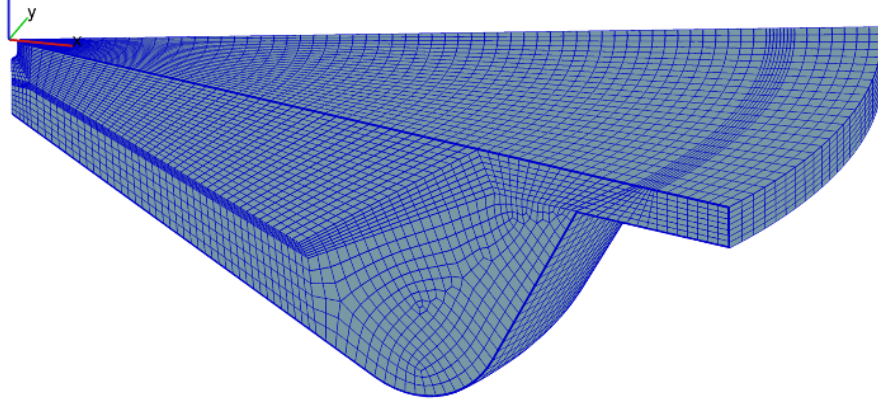
Figure 3. The 3D computational mesh of the combustion chamber at TDC.